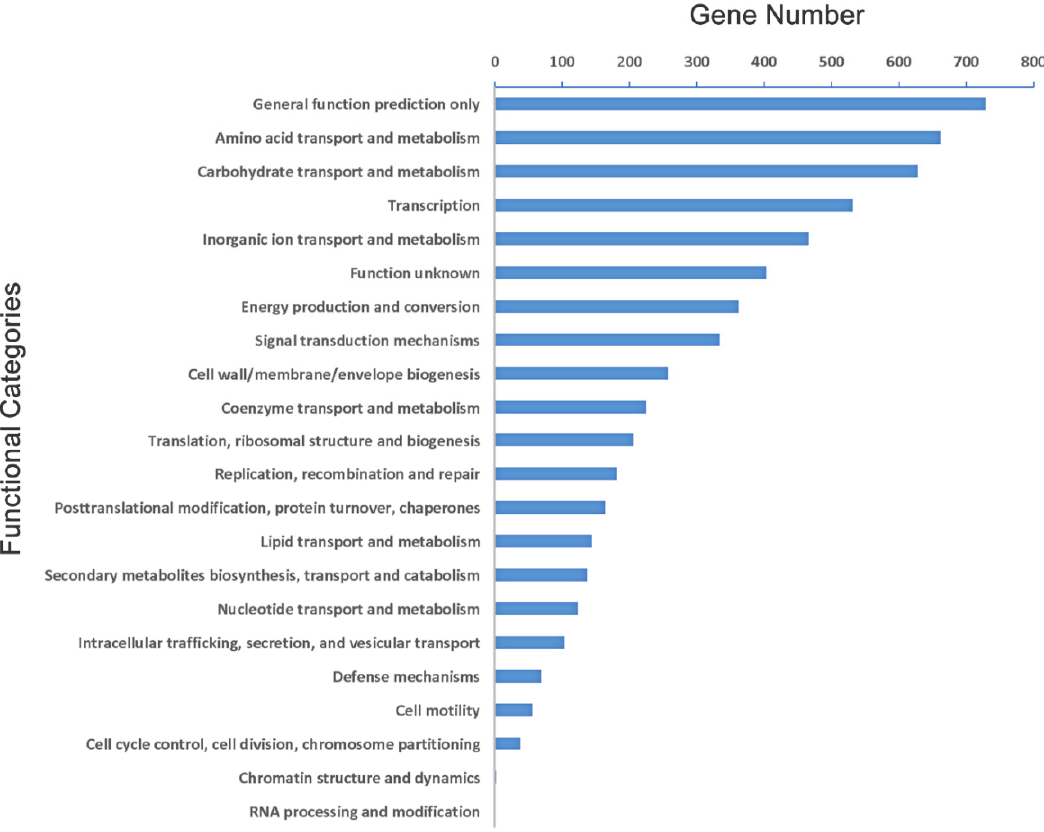
Figure 2. Analysis of COG functional of genome features of KpC4.